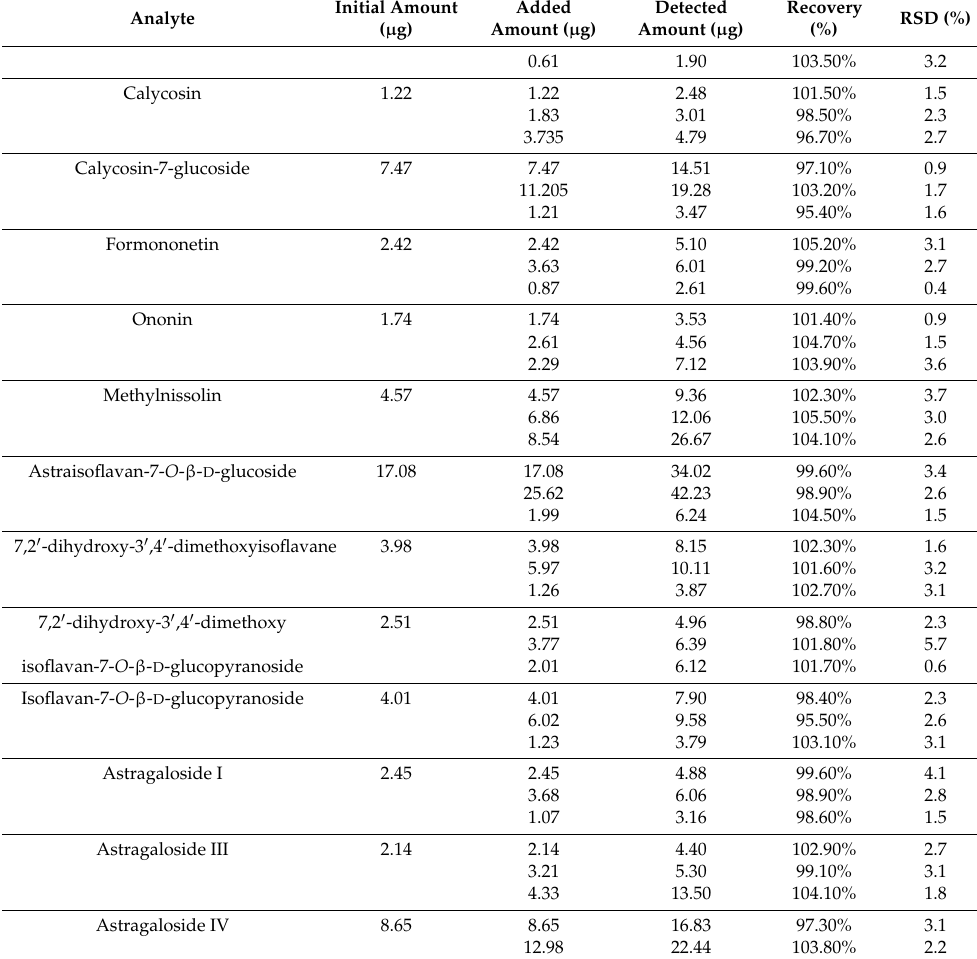
Table 3. Results of